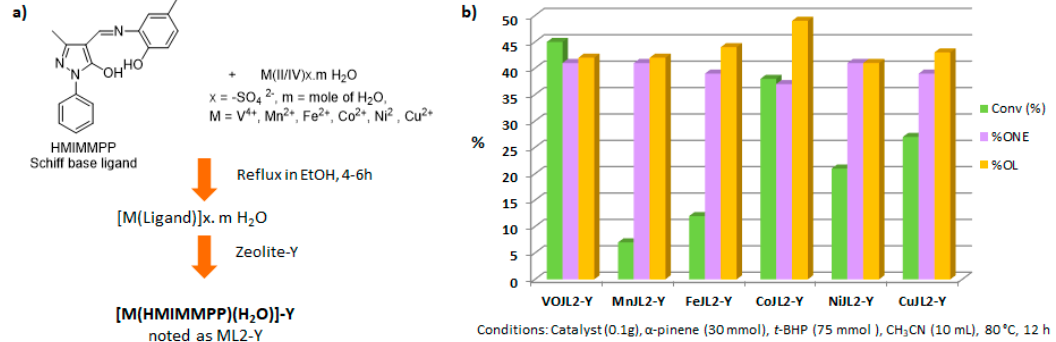
Figure 15. ( a ) Synthesis of zeolite-Y entagled M(II / IV) complexes. ( b ) Comparison of their catalytic activities in oxidation of α -pinene 1 (adapted from reference [85]).